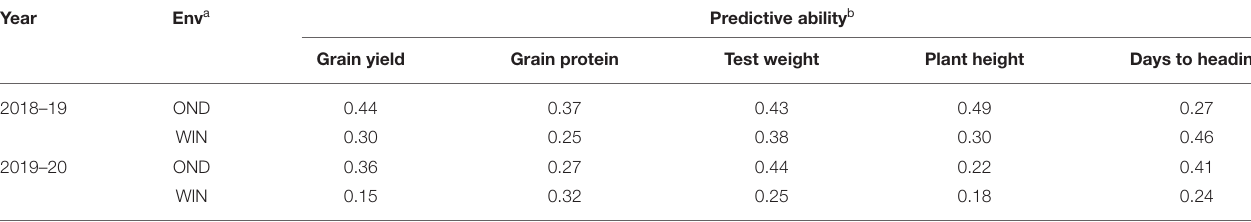
TABLE 2 | Predictive ability for the independent prediction of advanced breeding lines (AYTs) in new environments using the MTME